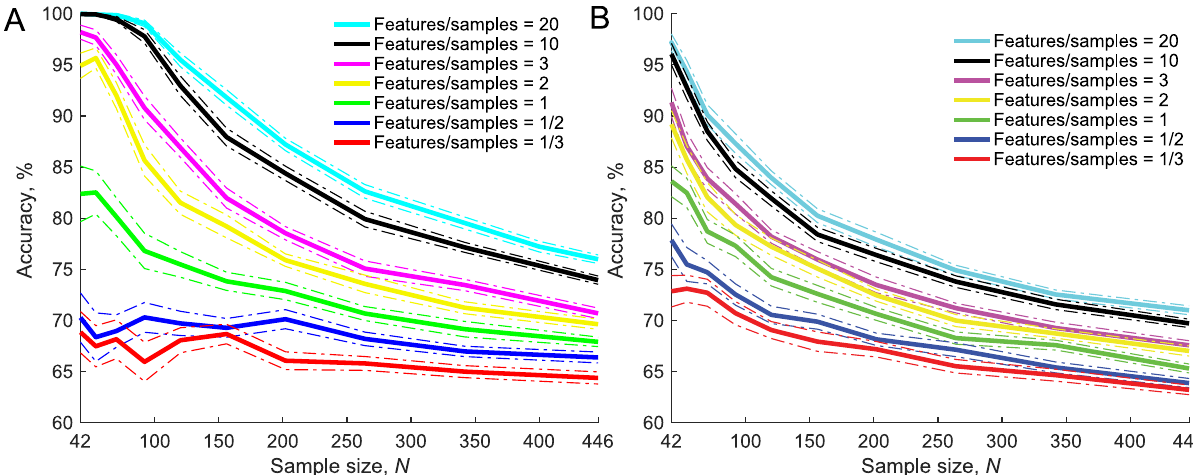
Fig 6. K-Fold CV with different feature-to-sample ratios. Sample size ranged from 14 to 446 and feature number was set accordingly to keep feature- to-sample ratios at 20, 10, 3, 2, 1, 1/2 and 1/3. A : SVM-RFE feature selection and SVM classifier. B : t -test feature selection and logistic regression